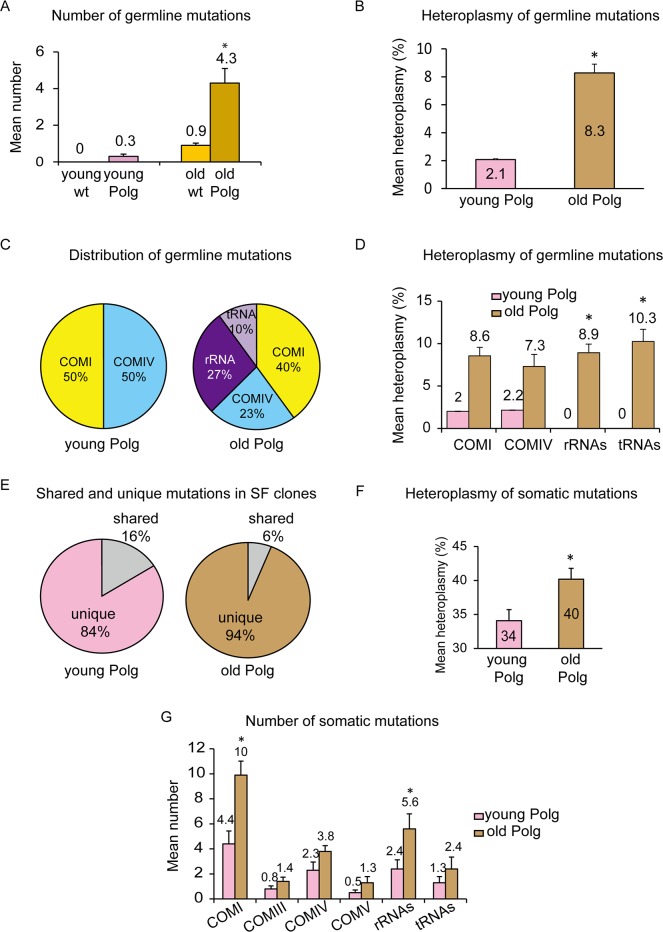
Characterization of mtDNA mutations in homozygous Polg mice with aging.(A). Comparison of mean number of germline mutations in wt and Polg mice at young and old age (n = 31 for young wt, n = 8 for young Polg, n = 44 for old wt and n = 14 for old Polg). Error bars, mean ± SEM. Asterisk indicates a significant increase in the number of mutations per tissue in old Polg compared to the old wt (P < 0.05, Student’s t-test). (B). Mean heteroplasmy levels of non-synonymous germline mutations with ≥2% heteroplasmy in Polg mice (mean ± SEM; asterisk, P < 0.05, Student’s t-test). (C) Pie charts showing gene distributions of non-synonymous germline mutations in young Polg mice (2 months, left) and old Polg mice (9 months, right). (D) Bar graphs representing the mean heteroplasmy levels of non-synonymous germline mutations in protein-coding and RNA-coding genes in Polg mice (asterisks, P < 0.05, Student’s t-test). (E) Pie charts showing the distribution of shared and unique mtDNA mutations detected in single skin fibroblast (SF) clones in young and old Polg mice. (F) Mean heteroplasmy changes for non-synonymous somatic mutations with ≥15% heteroplasmy in Polg mice. Error bars, mean ± SEM. Asterisk, P < 0.05, Student’s t-test. (G) Changes in number of non-synonymous somatic mutations with heteroplasmy levels ≥ 15% among different gene types with Polg mice aging. Error bars, mean ± SEM. Asterisks, P < 0.05, Student’s t-test.